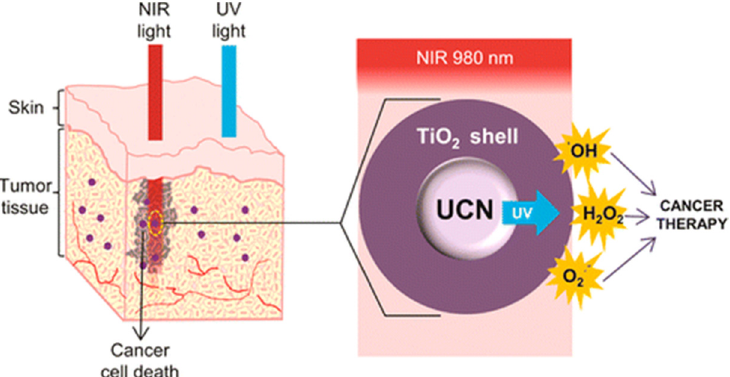
Figure 16. Schematic illustration of the NIR-driven reactive oxygen species generation